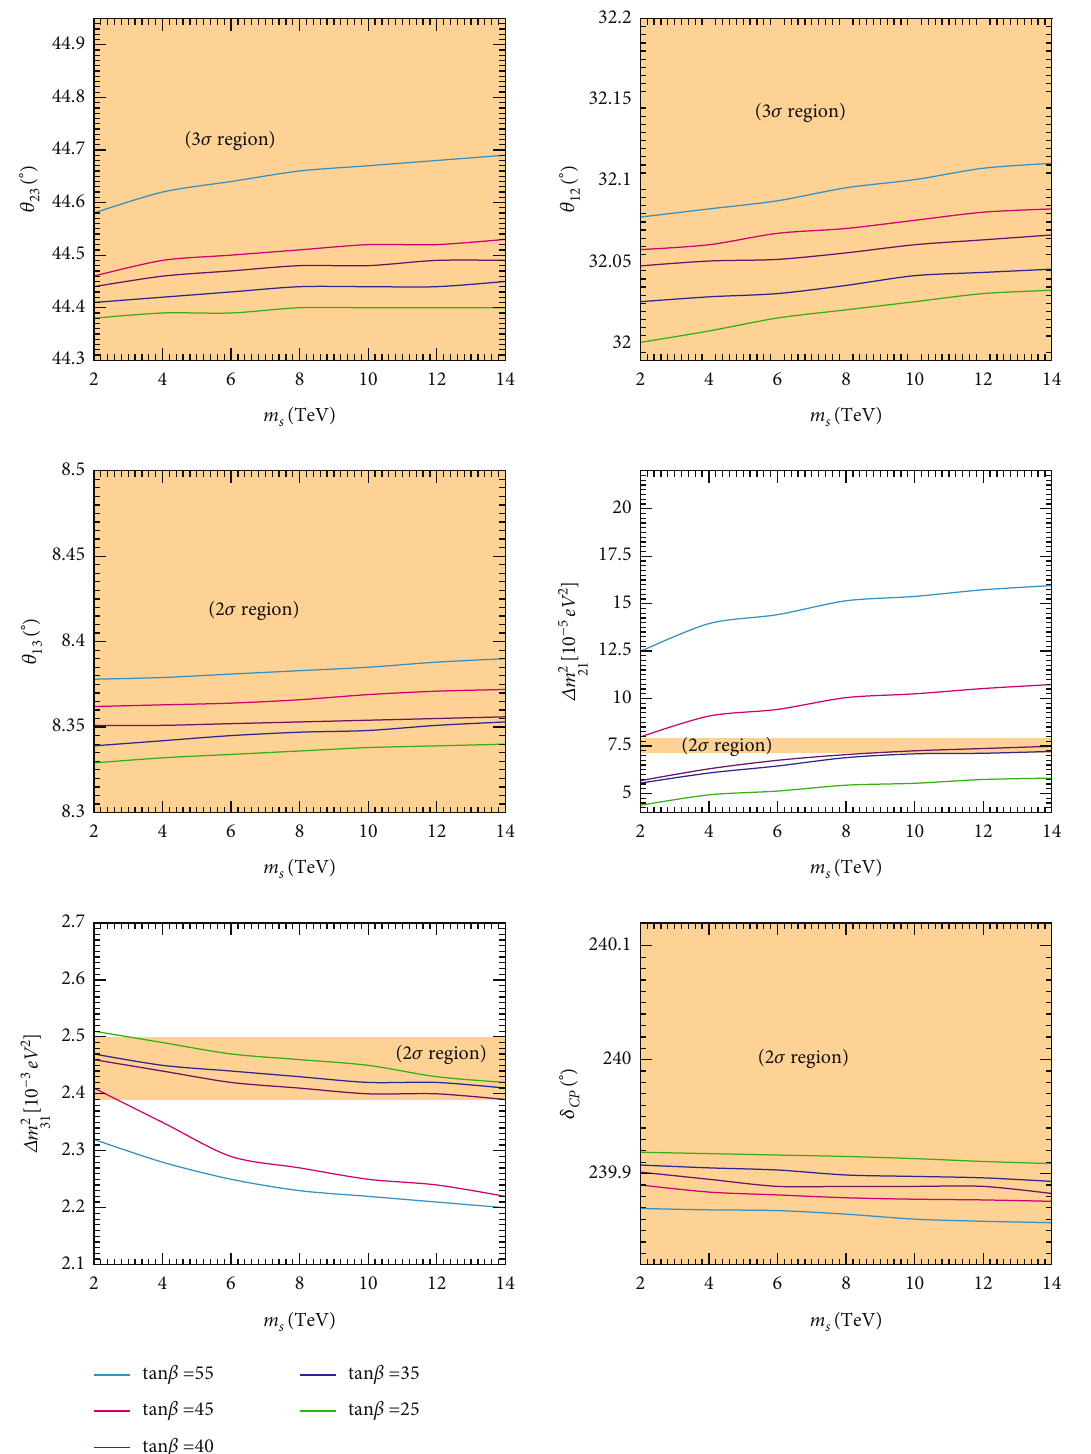
j , and δ , j Δ m 2 with variation of m CP ij ij